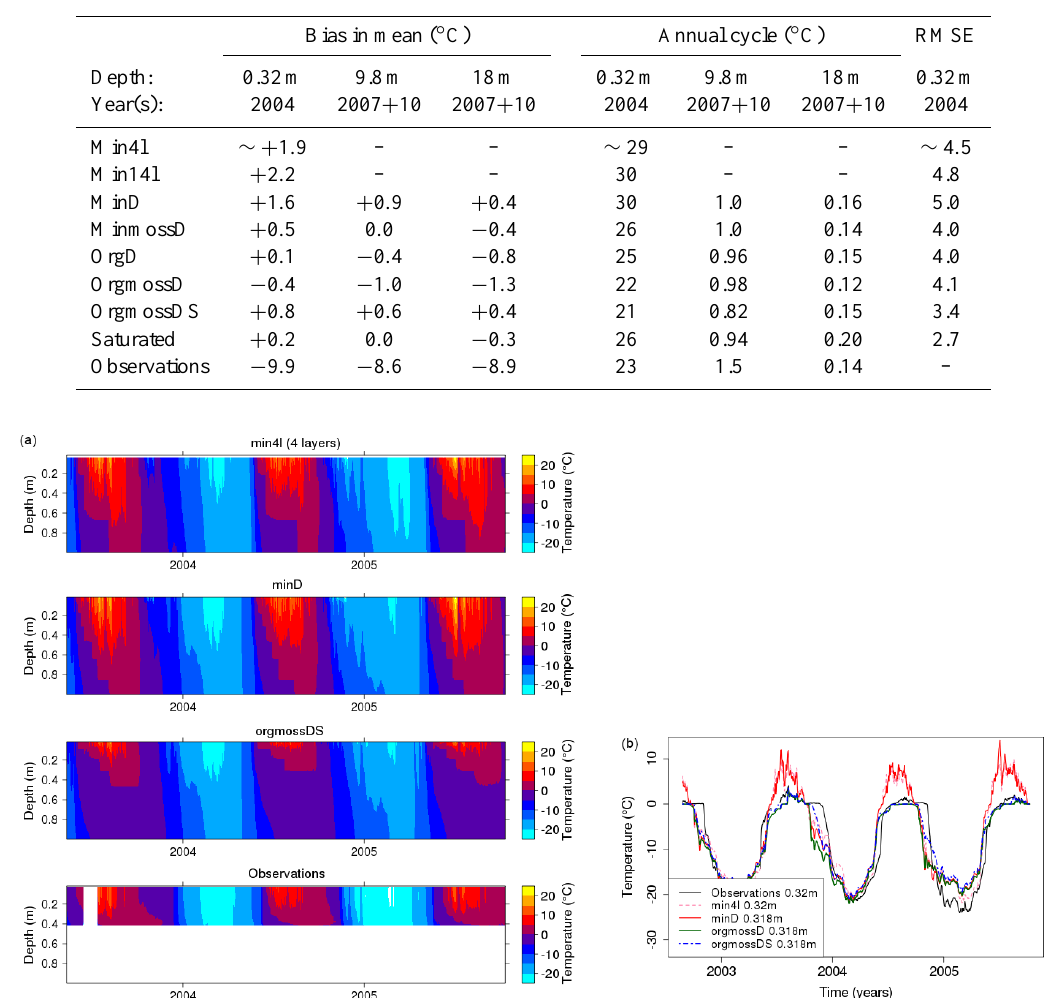
Table 2. Simulated and observed soil temperatures on Samoylov Island: annual means and amplitude of annual cycles. The observations (bottom row) give the actual mean temperature ( ◦ C) and the simulations give the bias relative to that mean. The 9.8 and 18m observations are from a 27m borehole. The 0.32m observations are from a polygon centre. Min4l simulation values are interpolated to 0.32m.